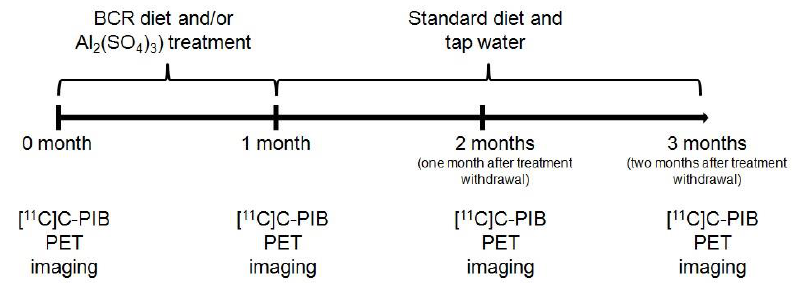
Figure 5. Study design. BCR: butter- and cholesterol-rich; PET: Positron Emission Tomography; [ 11 C]C-PIB: [ 11 C]C Pittsburgh compound B.